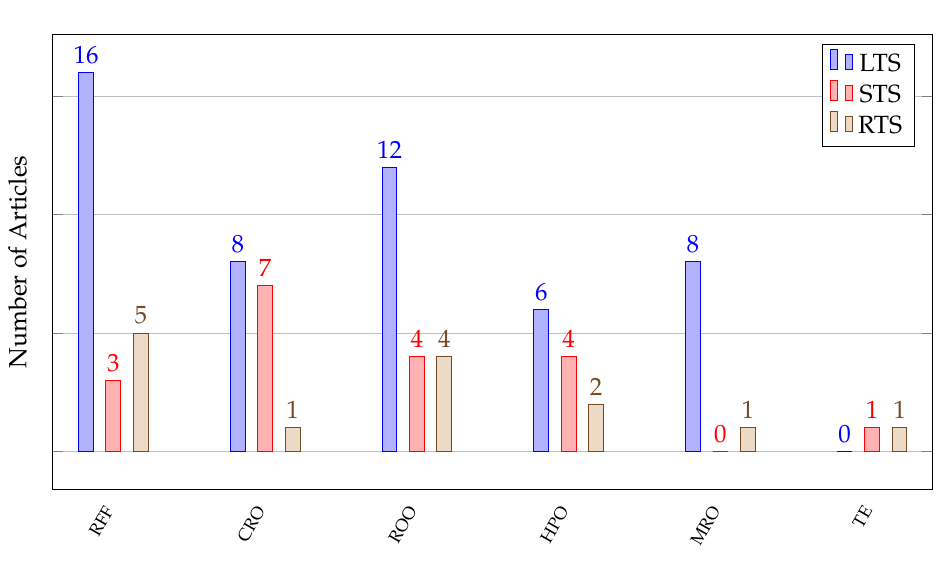
Figure 8. Machine Learning vs river system.